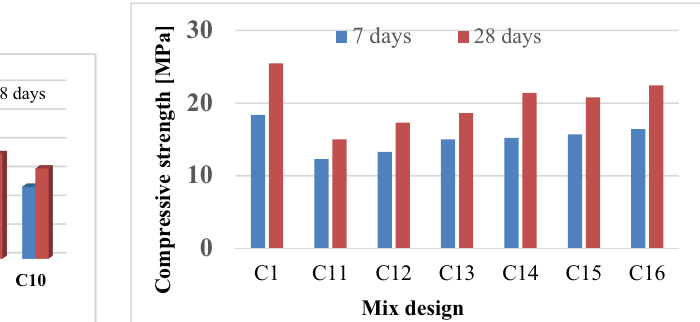
Figure 4: Compressive strength variation for trail mixes. Figure 5: Compressive strength for di ff erent